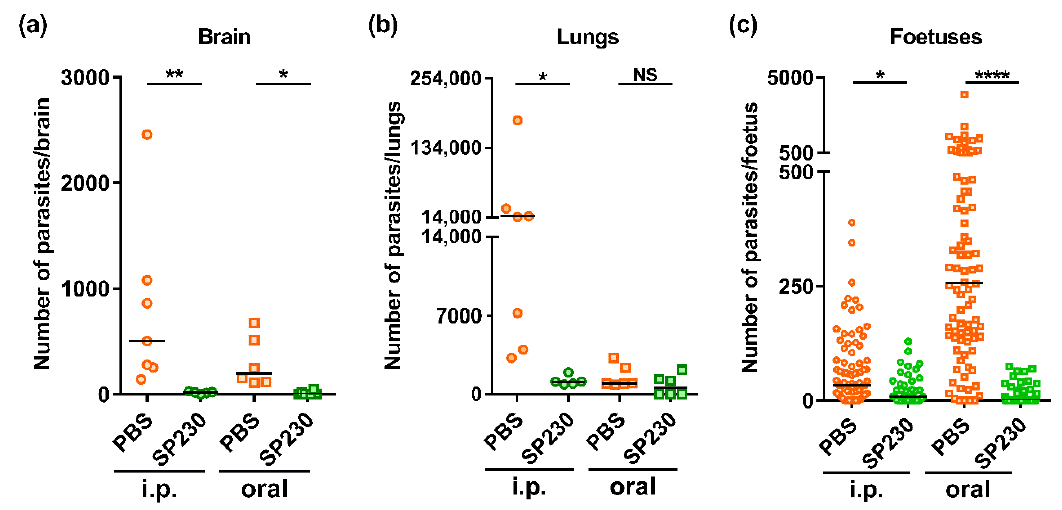
Figure 1. Mice were infected at mid-gestation by tachyzoites (intraperitoneal route, i.p.) or cysts (oral route) of the ME49 strain of T. gondii . Mice received PBS or SP230 (50 mg/kg) by the same routes for 5 days. The number of T. gondii parasites was evaluated by qPCR at day 17 of gestation in brain ( a ) and lungs ( b ) of dams ( n = 5 to 7) or in foetuses (( c ), n = 90 [PBS i.p., 5 dams], 47 [SP230 i.p., 3 dams], 86 [PBS oral, 6 dams] and 53 [SP230 oral, 3 dams]). NS: not significant, * p < 0.05, ** p < 0.01, **** p < 0.0001 (Dunn’s multiple comparison test).